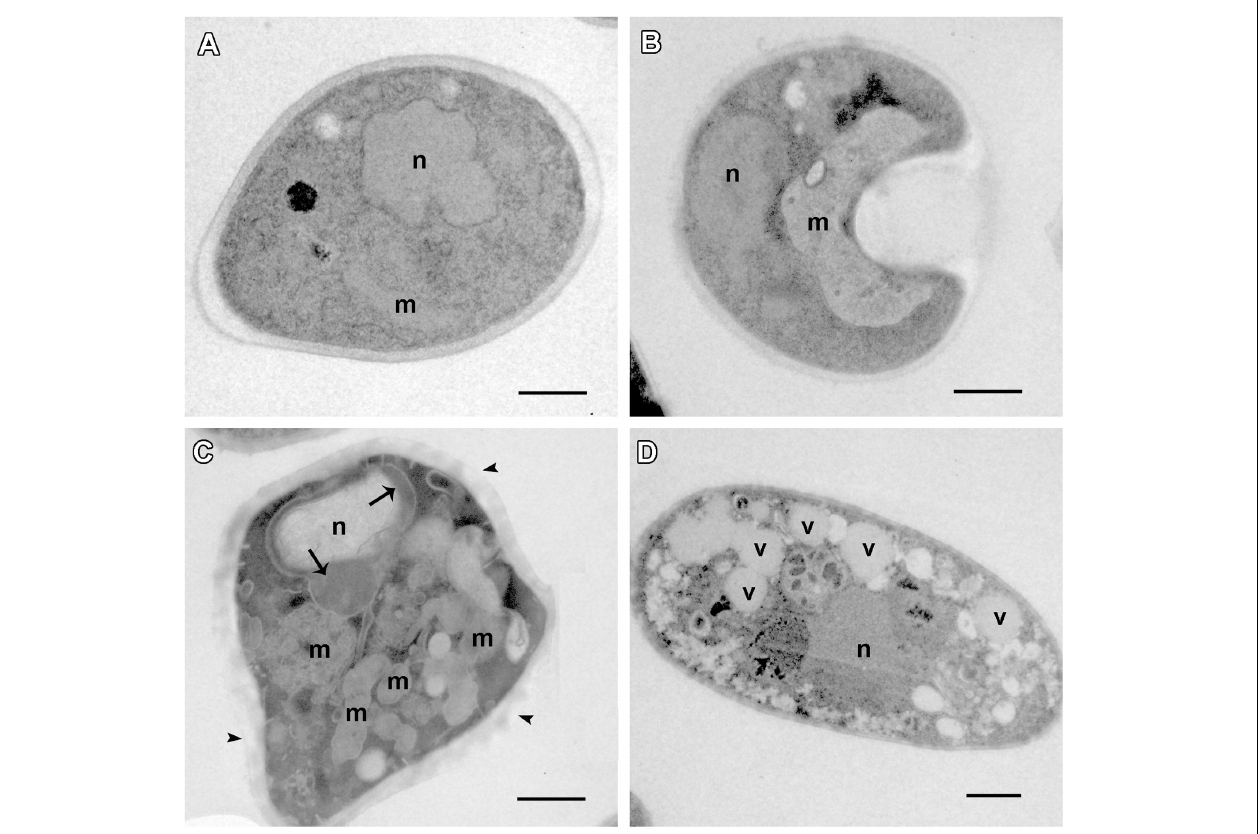
FIGURE 2 | Morphological alterations were observed in C7a-treated cells. Transmission electron microscopy of Candida albicans ATCC 10231 yeast cells untreated (A) and treated with 0.5 µ g/ml of C7a (B–D) for 24 h at 37 ◦ C in RPMI 1640 buffered with MOPS 0.16 M. n, nucleus; m, mitochondria; v, vacuole. Bars = 1 micrometer. DNA marginalization is pointed with arrows and damage at cell wall with arrowheads in